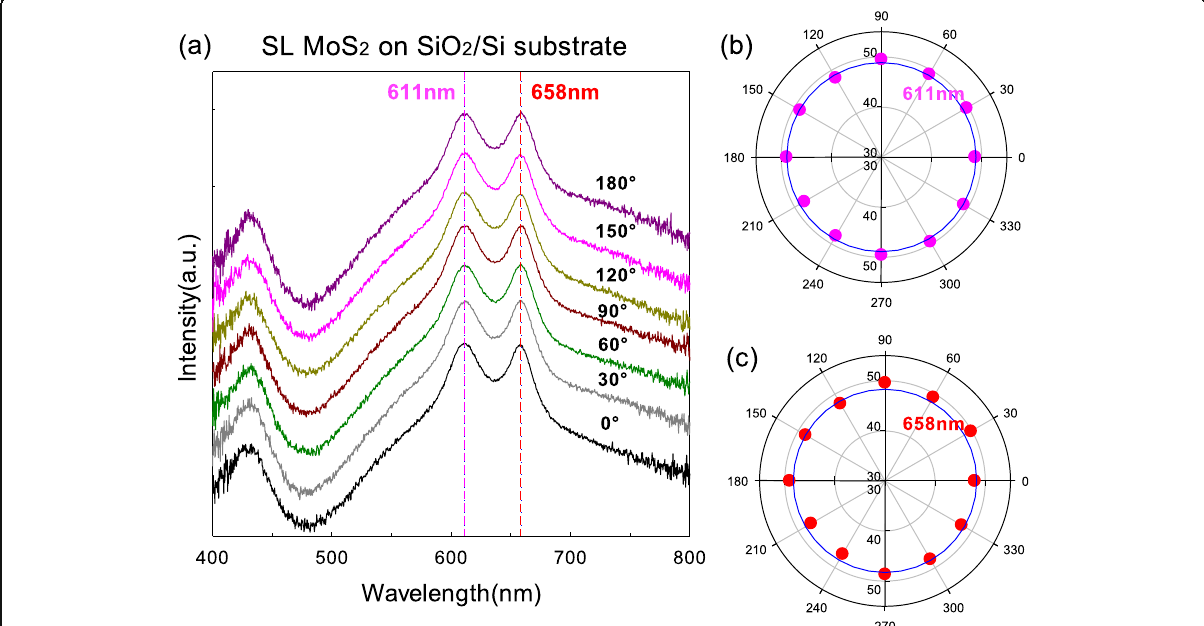
Fig. 1 a The polarization optical contrast curves of SL MoS 2 flakes supported on SiO 2 /Si substrate. b The intensity variation at ~ 611 nm from 0 to 360°. c The intensity variation at ~ 658 nm from 0 to